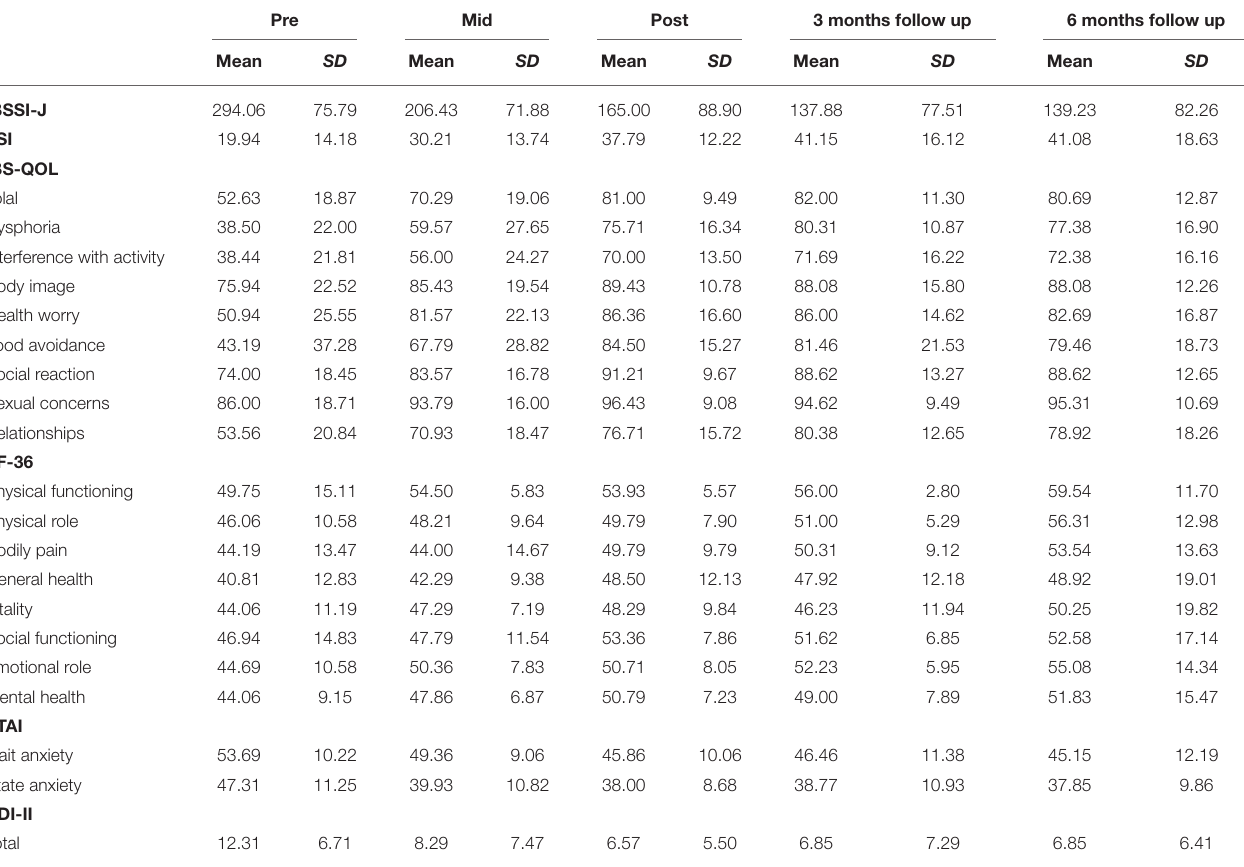
TABLE 4 | Descriptive statistics of outcome measures (mean and standardized deviation). Pre Mid Post 3 months follow up 6 months follow